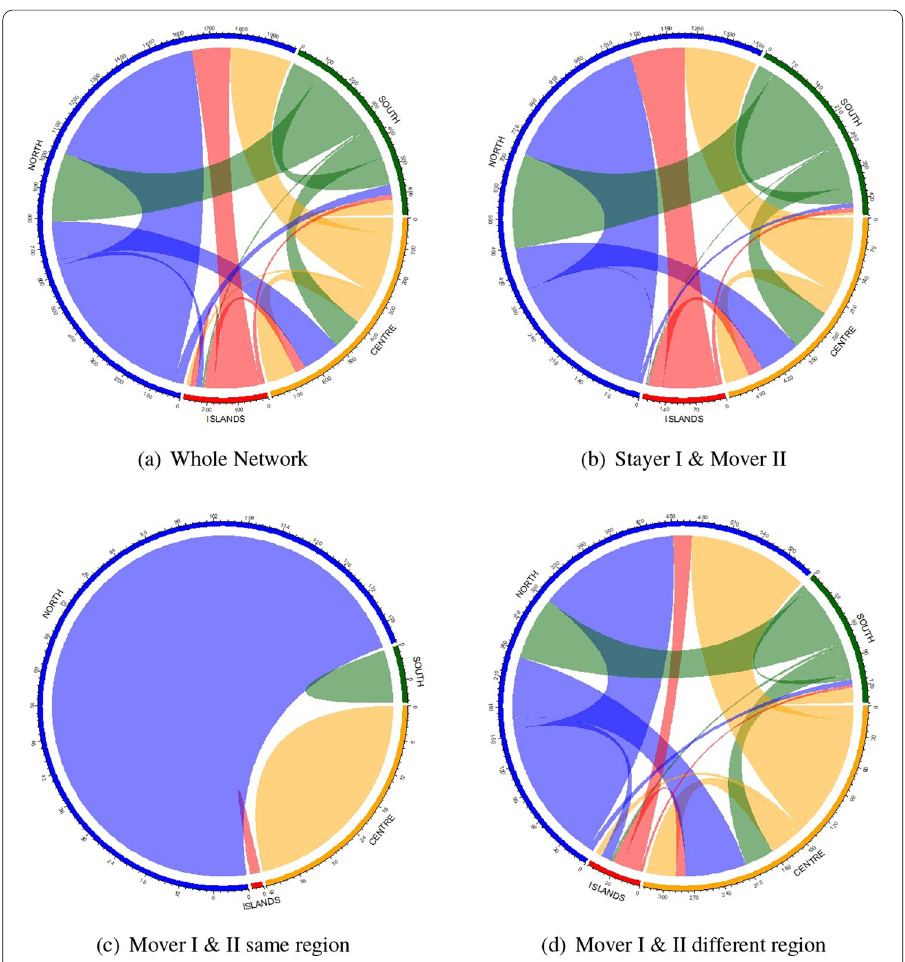
Fig. 3 Chord diagrams of overall student mobility and networks derived from the profiles of the 2014–15 cohort according to Italian macro-areas (blue